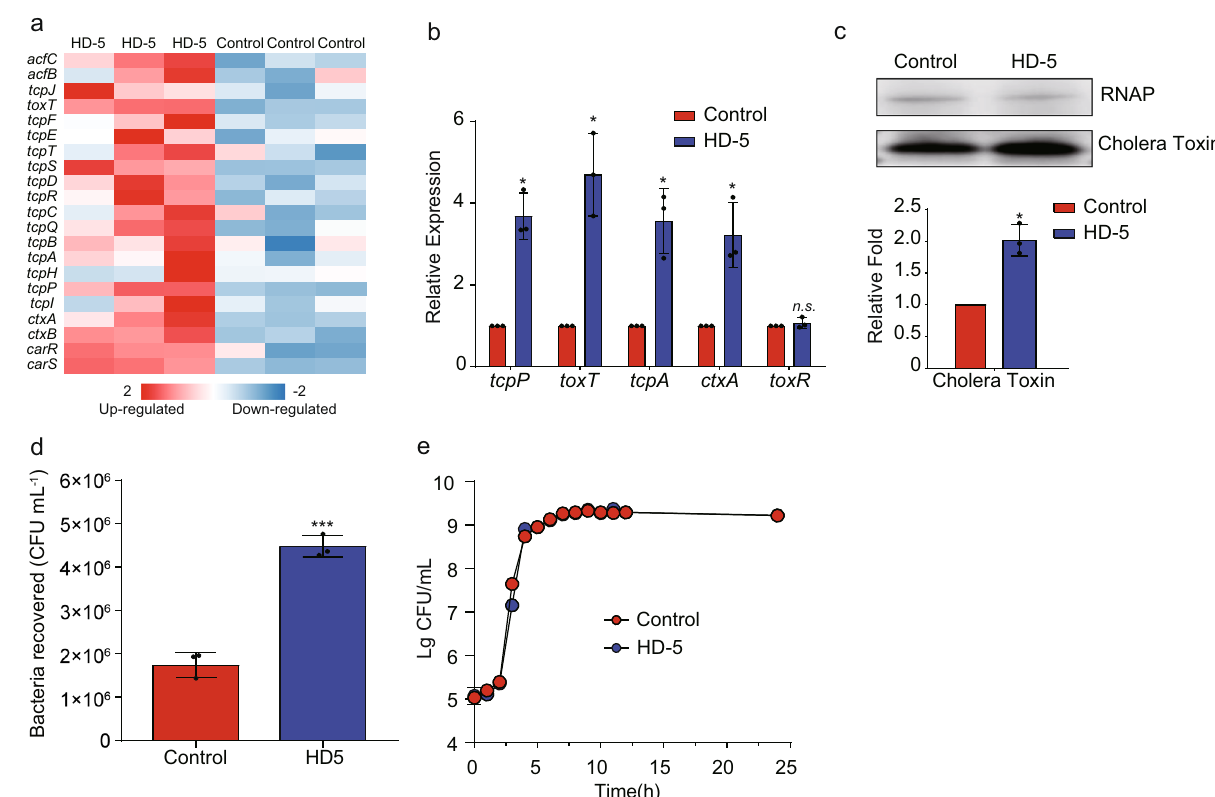
Fig. 2 HD-5 in fl uences V. cholerae colonization and virulence gene expression. a Heatmap of differentially expressed genes in AKI medium containing 0 and 50 μ g/mL HD-5. The z score indicates whether the genes were upregulated (red) or downregulated (blue). b qRT-PCR analysis of virulence genes expression in AKI medium containing 0 (Control) and 50 μ g/mL HD-5 (HD-5). Data are presented as mean ± SD ( n = 3). c Western blotting and quantitative analysis of cholera toxin in AKI medium containing 0 and 50 μ g/mL HD-5. RNA polymerase (RNAP) was used as a control. Data are presented as mean ± SD ( n = 3). d Adherence of V. cholerae to Caco-2 cells containing 0 and 50 μ g/mL HD-5. Data are presented as mean ± SD ( n = 3). e Growth of V. cholerae in AKI medium containing 0 and 50 μ g/mL HD-5. Data represents the mean ± SD ( n = 3). Signi fi cance was determined by two-tailed unpaired Student ’ s t test ( b – d ). * P ≤ 0.05; ** P ≤ 0.01; *** P ≤ 0.001; n.s. no signi fi cant